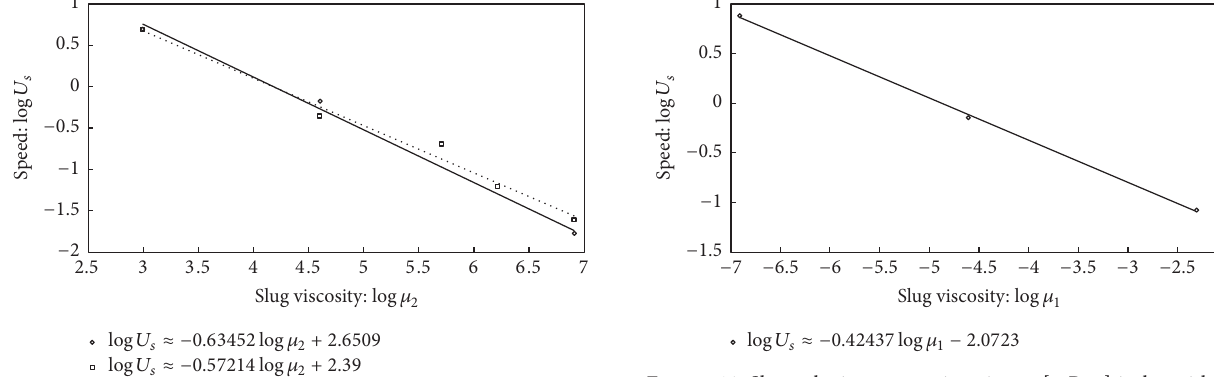
Figure 13: Slug velocity versus viscosity 𝜇 2 [mPa ⋅ s] in logarithmic scale; numerical result, approximated by log 𝑈 𝑠 ≈ −0.63452 log 𝜇 2 + 2.6509 , is graphed in solid line; experimental result extracted from earlier work approximated by log 𝑈 𝑠 ≈ −0.57214 log 𝜇 2 + 2.39 is in dotted line. The radius of the capillary tube is 0.51 [mm], and the successive lengths are 𝑙 1 = 16 [mm] and 𝑙 2 = 16.5 [mm]; also, the viscosity 𝜇 1 = 17 [mPa ⋅ s] is kept constant.